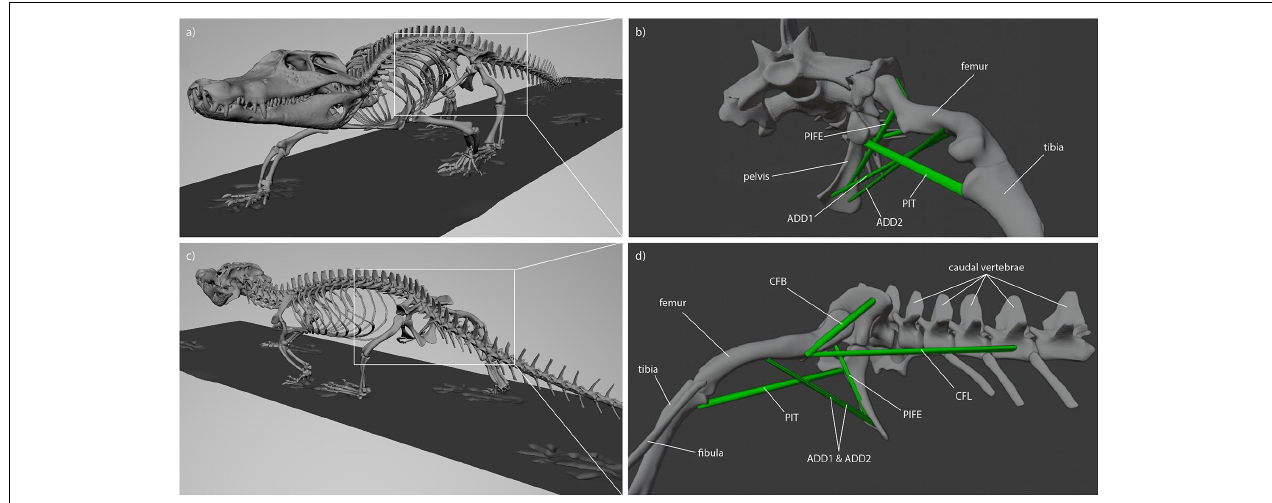
FIGURE 2 | Muscle attachments and lines of action in Caiman (see Otero et al., 2010). (a) Latero-frontal view of Caiman , (b) latero-frontal view of relevant skeletal elements to show adductor muscles (ADD1, ADD2, PIFE 3rd head, PIT) at reference length (mid-stance), (c) latero-caudal view of Caiman , (d) latero-caudal view of relevant skeletal elements to show retractor muscles (CFB, CFL) at reference length